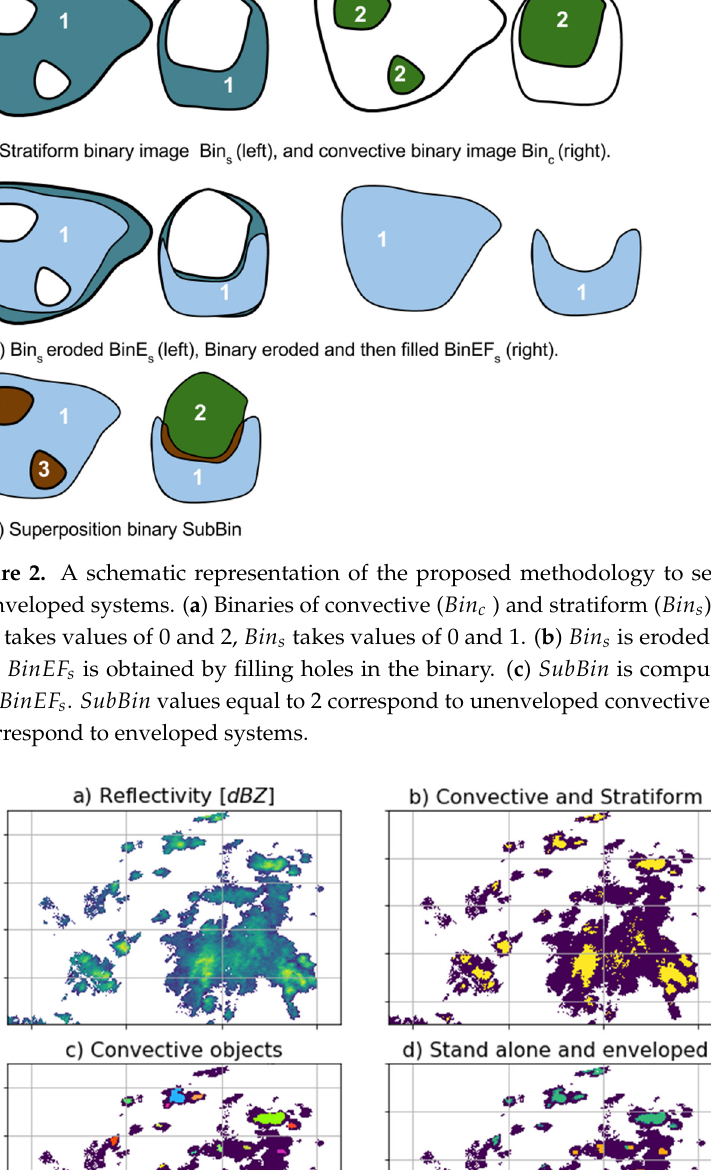
Figure-3. Example of a classified radar image. ( a ) Original reflectivity image in dBZ, ( b ) identifica- tion of convective (yellow) and stratiform systems (purple), ( c ) ID assignation to each convective system, and ( d ) identification of enveloped (orange) and unenveloped (green) systems.